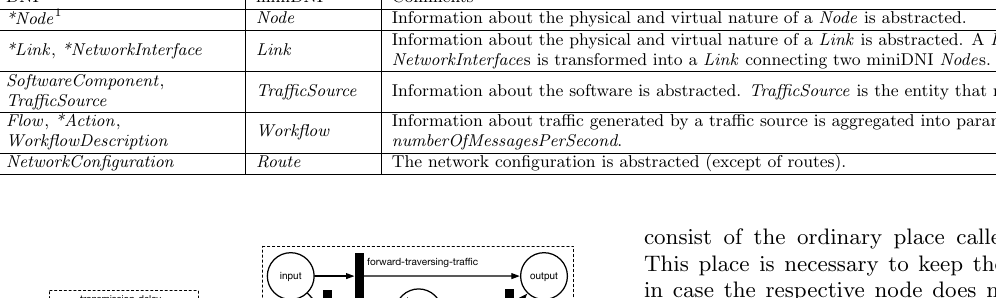
Table 1: Selected transformation rules from the DNI-to-mDNI transformation DNI